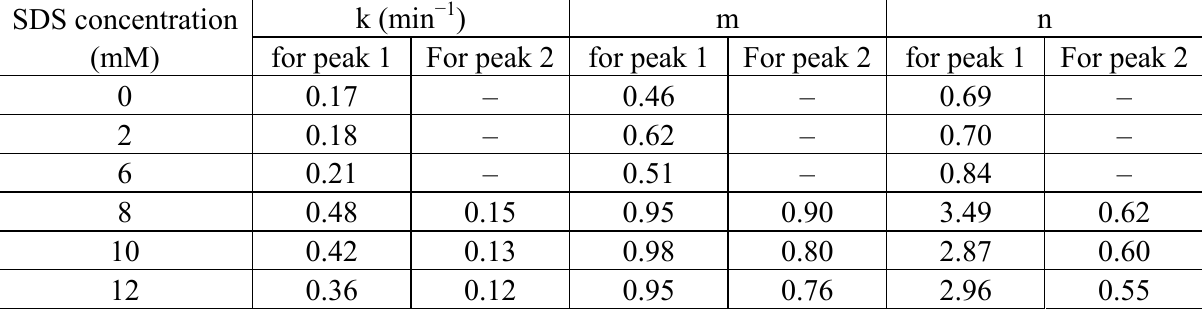
Table 4. Kinetic parameters for non-isothermal gelation of 1.0wt%